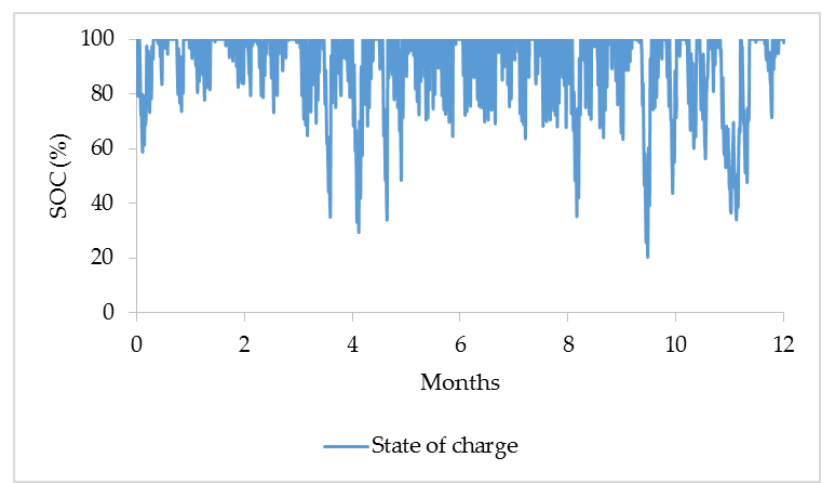
Figure 9. Battery SOC during the year.